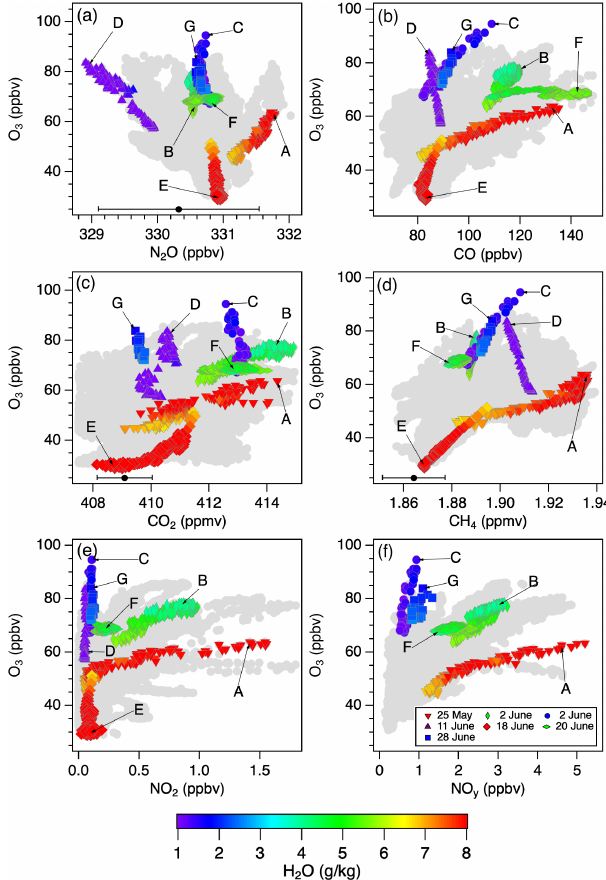
Figure 17. Scatterplots showing the relationships between O 3 and the (a) N 2 O, (b) CO, (c) CO 2 , (d) CH 4 , (e) NO 2 , and (f) NO y tracers on AP during episodes A–G. The gray points show all of the FAST -LVOS measurements. The black points with error bars in (a) , (c) , and (d) represent the mean ( ± 1 σ ) June 2017 concentrations from the NOAA GML Mauna Loa